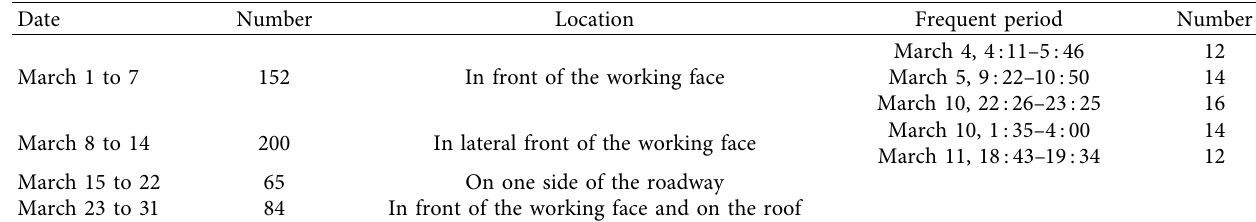
Table 3: Statistics of roadway coal